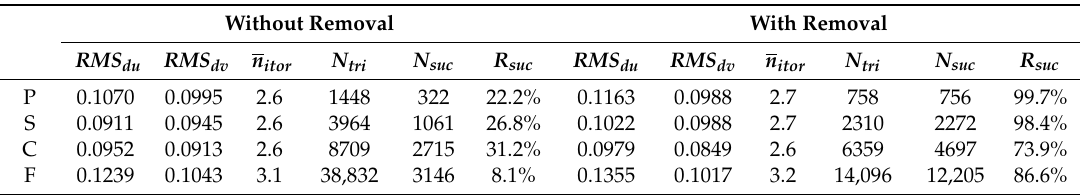
Table 1. Comparison of seed point generation without and with proposed two-step method for removing wrong matches (unit of RMS: